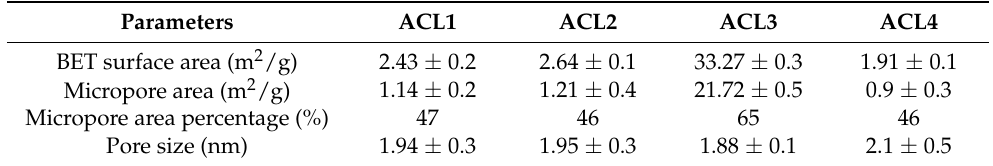
Table 1. Physical adsorption properties of ACL.